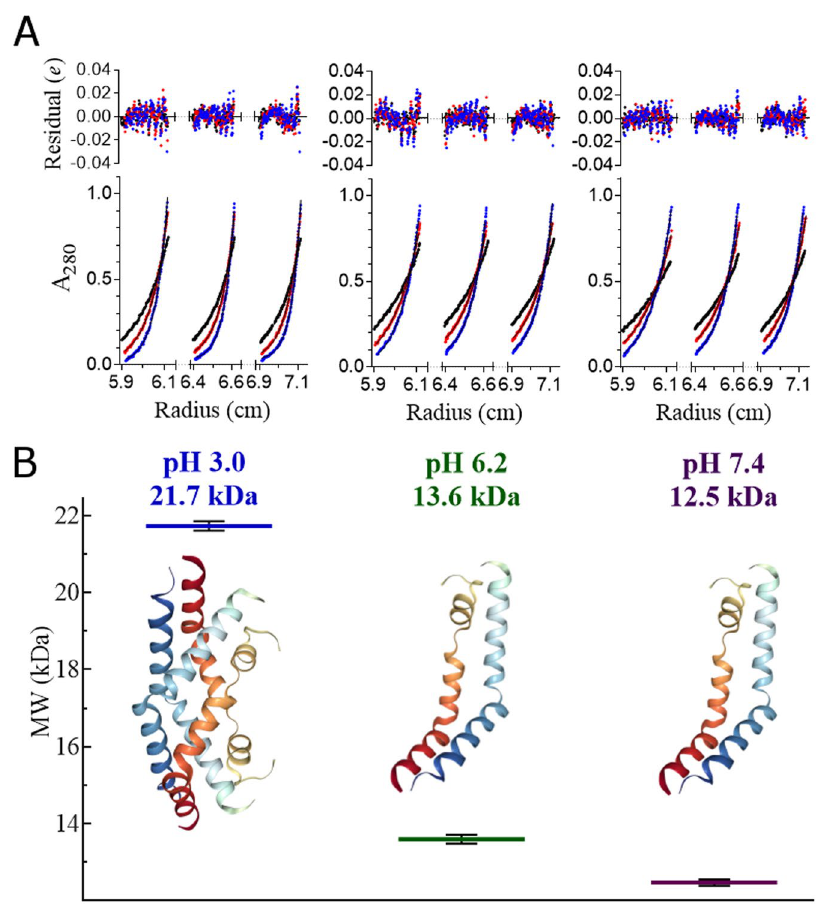
Figure 2. Sedimentation equilibrium analytical centrifugation analyses at pH 3.0, 6.2, and 7.4. ( A ) Absorbance measurements at 280 nm collected in 0.002 cm radial steps and averaged over 10 readings; measurements were determined in triplicate. ( B ) Summary of the calculated masses from matching tests (mean + / − one standard deviation, n = 6). The respective buffers used were 27 mM sodium phosphate pH 3.0, 20 mM sodium phosphate pH 6.2, and 10 mM sodium phosphate pH 7.4, all containing 140 mM